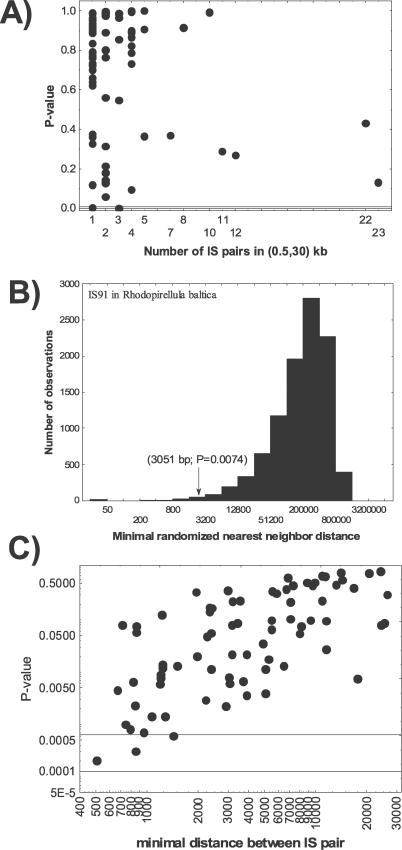
No Significant Enrichment of Composite Transposons in 376 Completely Sequenced Bacterial Genomes and Plasmids(A) The horizontal axis shows the number of nearest-neighbor IS pairs at a distance between 0.5 and 30 kb in the bacterial genomes examined. The p-value on the vertical axis is the likelihood that this number of IS pairs is greater than expected by chance alone, according to a randomization test described in Materials and Methods. There are two horizontal lines near the horizontal axis. The upper line represents a p-value of 0.01, the lower line a p-value of 0.00064, which is the Bonferroni-corrected value of p = 0.05, given that n = 78 independent statistical tests carried out for this analysis (0.00064 = 0.05/78).(B) The randomized distribution of nearest-neighbor distance for IS91 in the genome of Rhodopirellula baltica. There are five members of this IS in the genome, and the closest pair of them is 3,051 bp apart. Based on this randomization test, this distance is significantly closer than expected by chance at a p = 0.0074.(C) The horizontal axis shows the minimal distance between nearest-neighbor IS pairs that are between 0.5 and 30 kb apart in a genome. The vertical axis shows the likelihood that this minimal distance is observed by chance alone, based on the randomization test from (B) (described in Materials and Methods). The upper and lower horizontal lines represent Bonferroni-corrected p-values of p = 0.05 (0.00064 = 0.05/78) and p = 0.01 (0.000128 = 0.01/78). Both panels contain n = 78 datapoints derived from ISs in 28 different families.